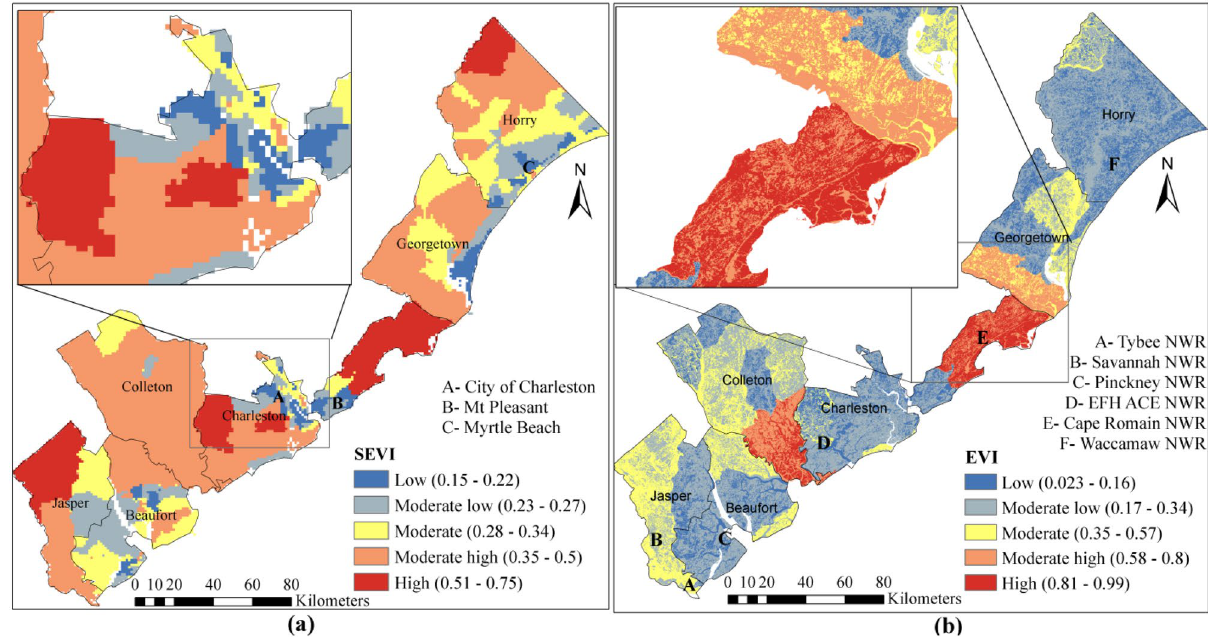
Figure 10. ( a ) Socio-economic vulnerability and ( b ) Ecological Vulnerability of SC